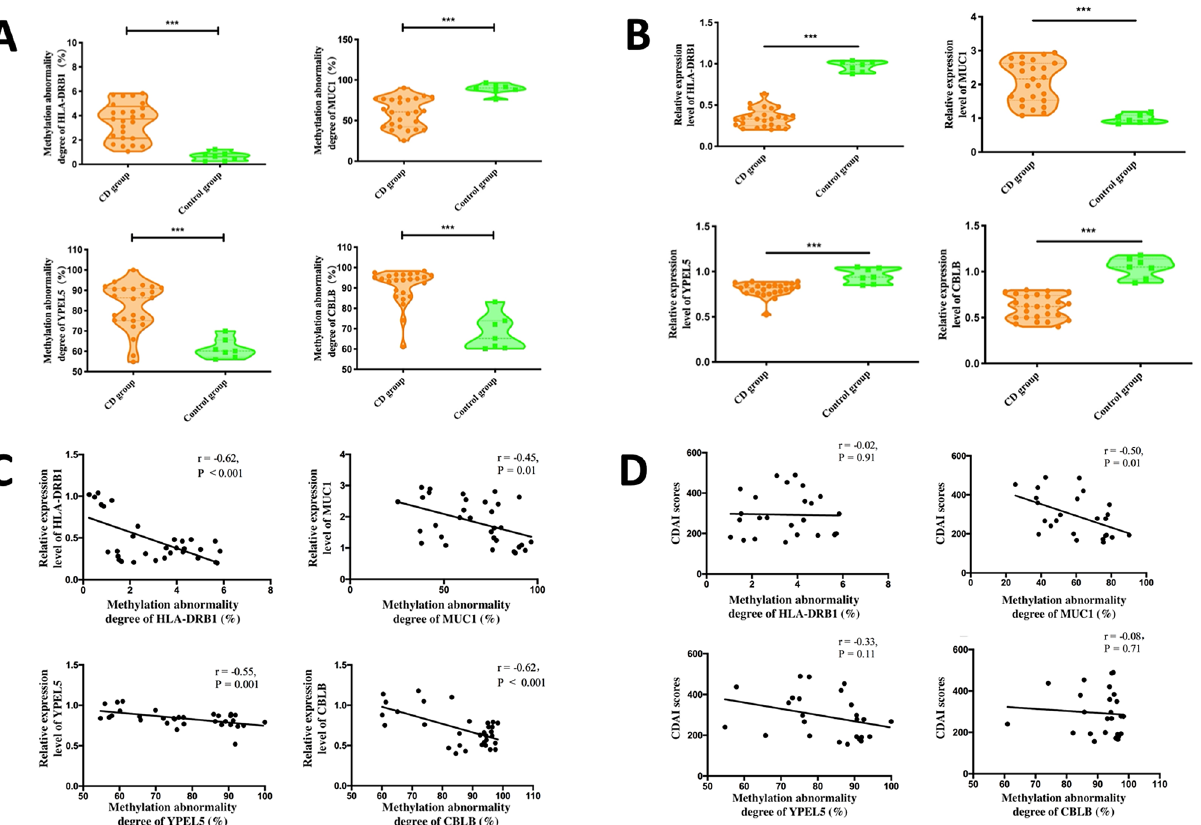
Figure 5. ( A ) The methylation abnormality degrees of HLA-DRB1, YPEL5, CBLB and MUC1 in the intestinal mucosal tissue of the CD group were verified by pyrosequencing. ( B ) The relative expression levels of HLA- DRB1, YPEL5, CBLB and MUC1in the intestinal mucosal tissue of CD group were tested by qPCR. ( C ) Correlation between methylation abnormality degrees of HLA-DRB1, YPEL5, CBLB and MUC1 and gene expression level. ( D ) Correlation between methylation degree of MUC1 and disease activity of CD. Figures were performed with Prism (Version 6.0c, https:// www. graph pad. com/ scien tific- softw are/ prism/).